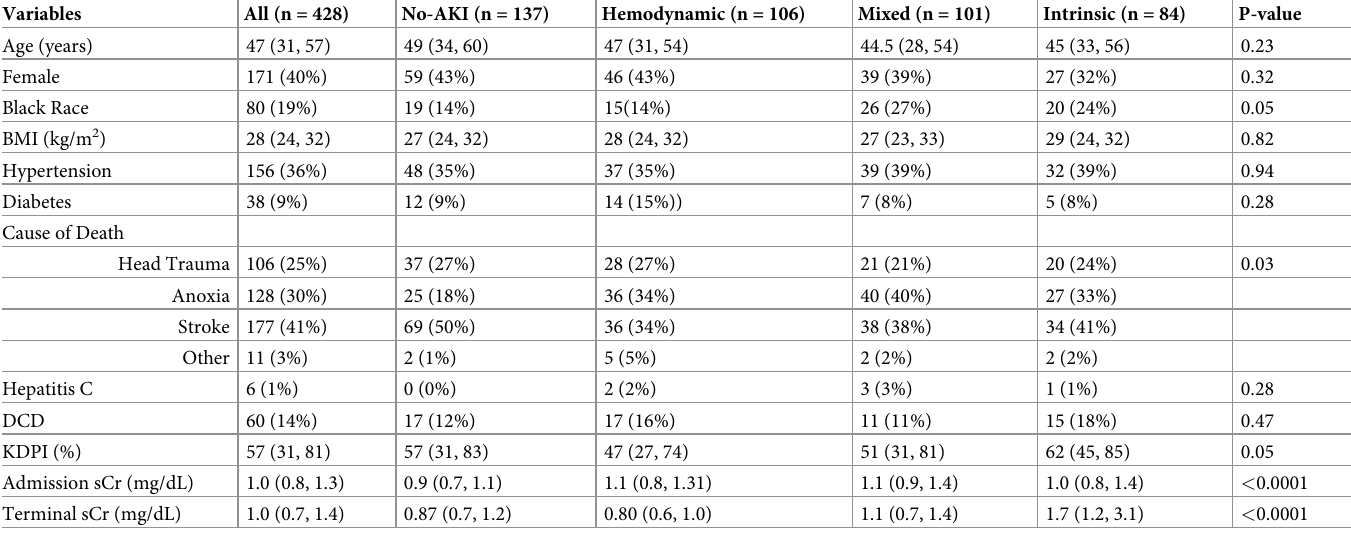
Table 1. Donor characteristics by AKI phenotype.